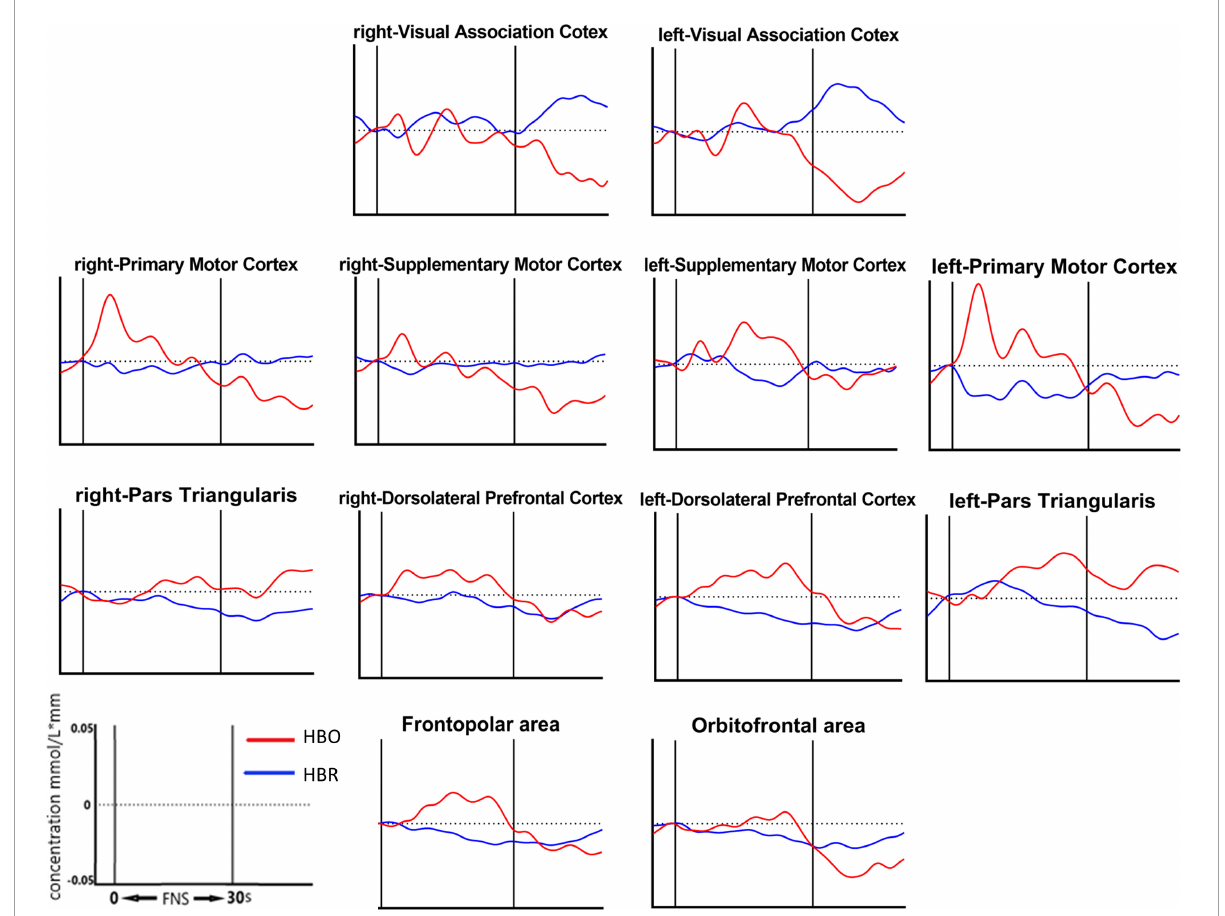
FIGURE4 Grand average waveforms of HBO changes during FNS in each ROI based on Brodmann in stroke patients. The vertical axis represents concentration changes of HBO and HBR; while the horizontal axis represents the latency. The start time of the FNS period was defined as 0 s. The ROI contained 12 cerebral areas, which include the bilateral Visual Association Cortex, bilateral Primary Motor Cortex, bilateral Supplementary Motor Cortex, bilateral Pars Triangular, bilateral Dorsolateral Prefrontal Cortex, Frontopolar area and Obitorfrontal